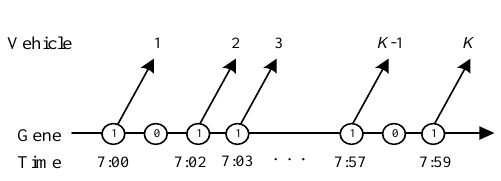
Fig. 4. The coding illustration of a chromosome for the outer genetic algorithm